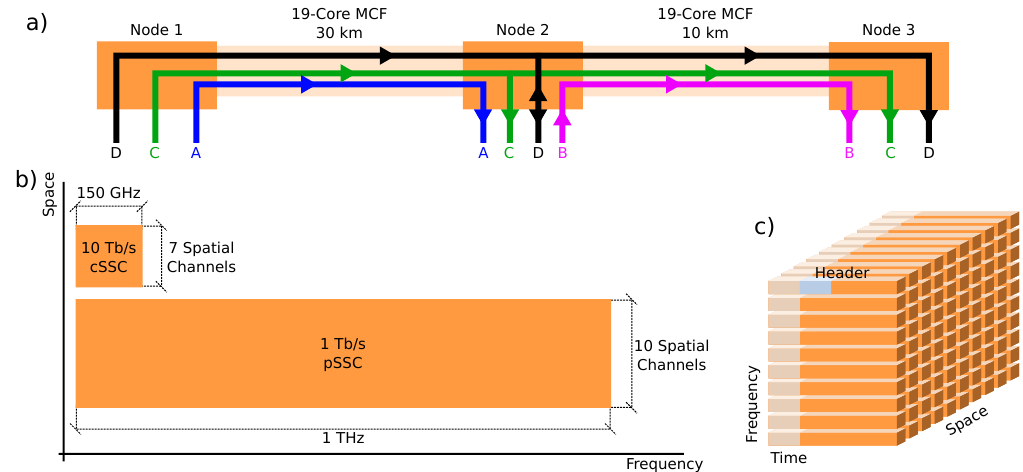
Figure 1. Testbed network structure ( a ) and channel allocation map ( b ); three-dimensional structure of the packet spatial super channels (pSSC) ( c